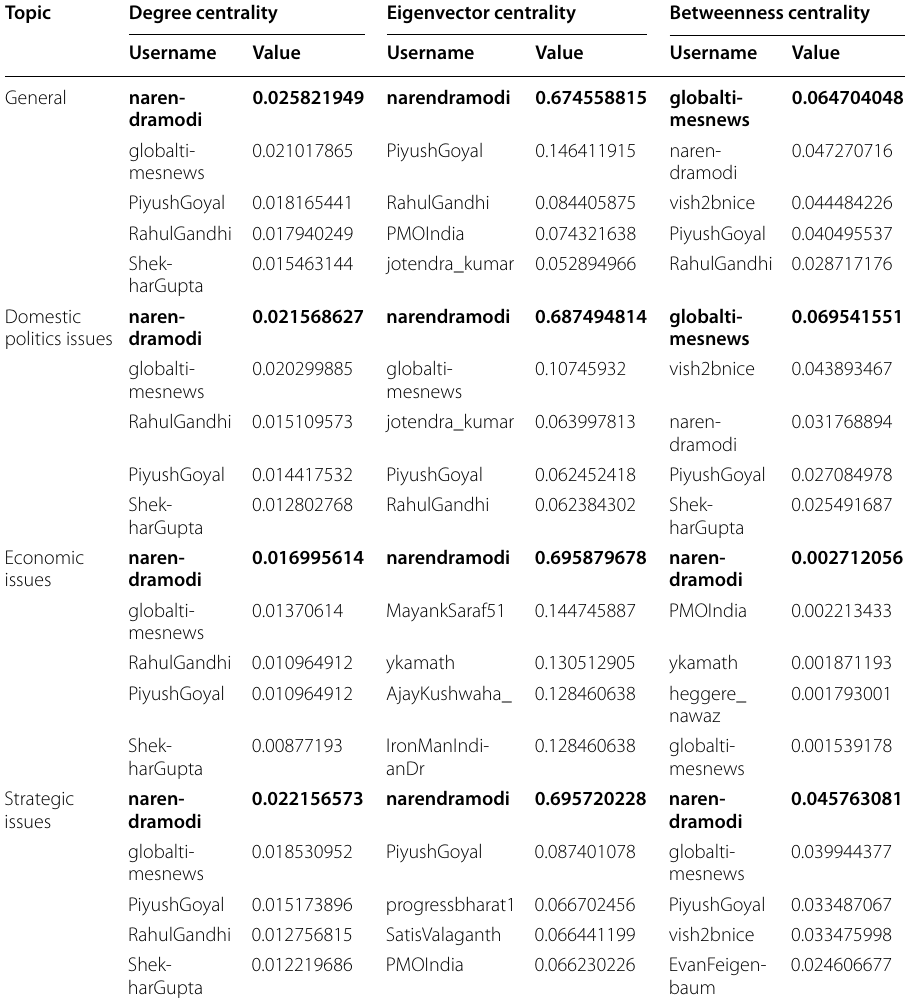
Table 3 Centrality in